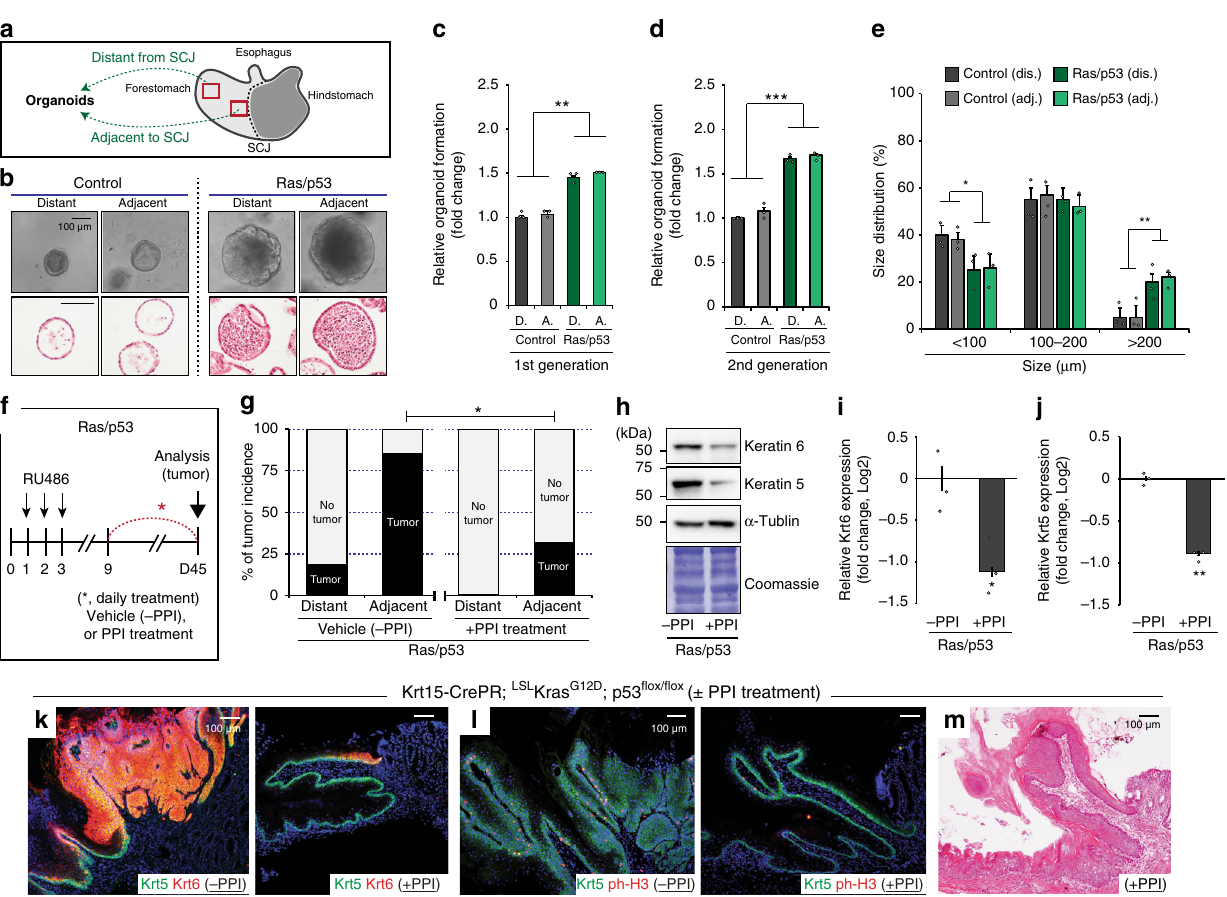
Fig. 4 Microenvironmental acidic stressors and tumor susceptibility. a Experimental scheme. Epithelial cells isolated from the regions adjacent or distant from squamocolumnar junction (SCJ). b Microscopic phenotype of three-dimensional (3D) organoids from control and Krt15-CrePR; LSL-Kras G12D ; p53 fl ox/ fl ox mice. Histology of 3D organoids demonstrated that oncogenic Ras/p53 increased abnormal growth features. c – e Quanti fi cation of relative organoid formation ( n = 3 independent experiments, 25 fi elds at high power fi eld (HPF) per sample) and size distribution ( n ≥ 150) from control and experimental mice expressing oncogenic Ras/p53 combination. f Experimental scheme. Phosphate-buffered saline (PBS) (vehicle) or PPI were daily treated by intraperitoneal (i.p.) injections (5 consecutive days per week). g Tumor incidence from Krt15-CrePR; LSL-Kras G12D ; p53 fl ox/ fl ox mice, with/without PPI treatment, n = 9 animals per each. Statistical signi fi cance was determined by Fisher ’ s exact test; * p < 0.05. h – j Immunoblotting of Keratin5 (Krt5) and Krt6 demonstrated relatively less tumor formation in the PPI treatment group, n = 5 independent experiments. k – m Immunostaining of Krt5, Krt6, and phospho- histone H3 (ph-H3), and histology demonstrated suppressed tumor formation by daily PPI treatment in Krt15-CrePR; LSL-Kras G12D ; p53 fl ox/ fl ox mice. PPI, proton pump inhibitor. Data with bar graphs are represented as mean ± SEM. Statistical signi fi cance was determined by pair-wise comparison using t